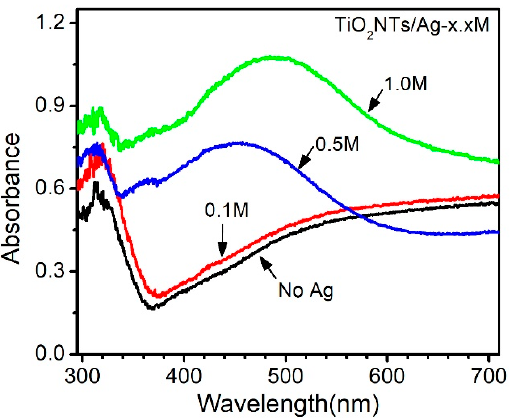
Figure 3. UV-vis diffuse reflectance spectra of TiO 2 NTs, TiO 2 NTs/Ag-0.1 M, -0.5 M and -1.0 M samples.